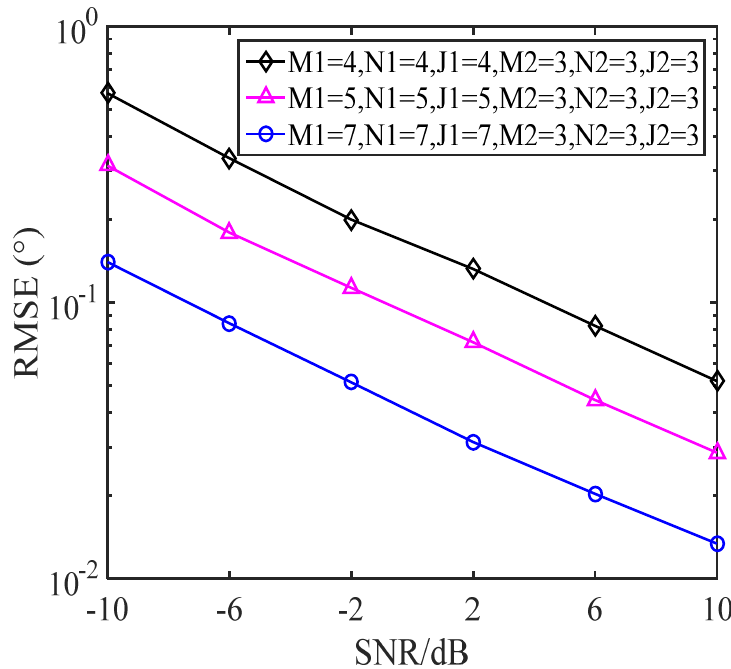
Figure 9. RMSE of various geometries against SNR levels.